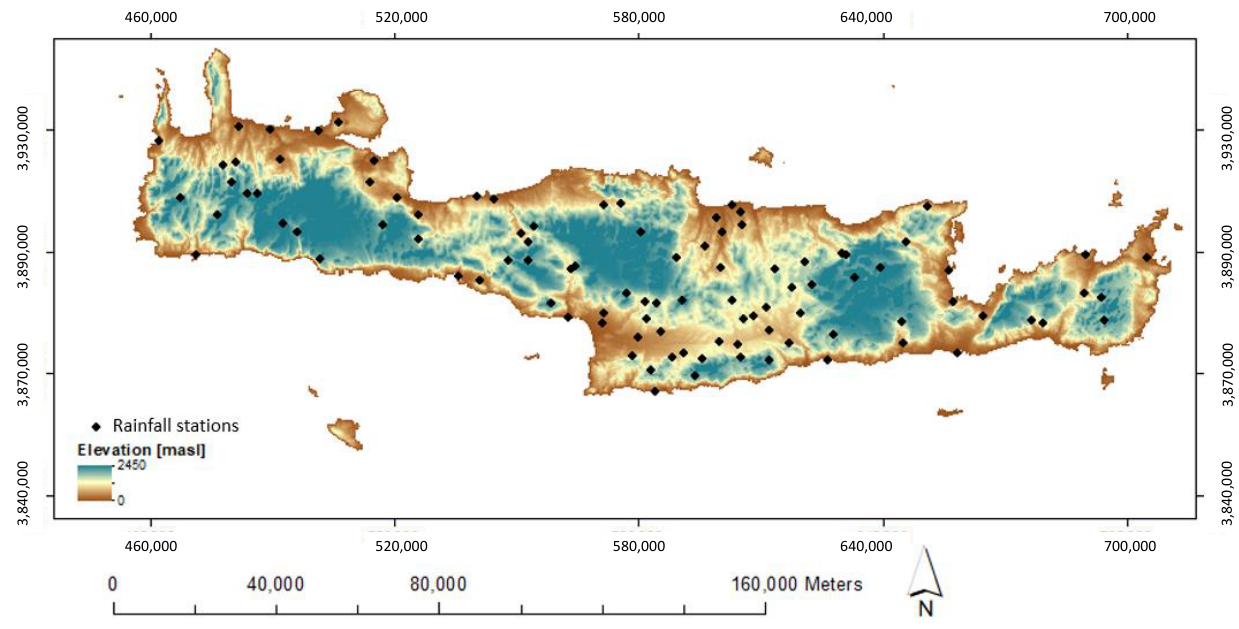
Figure 1. Spatial distribution of the rainfall stations at the island of Crete,